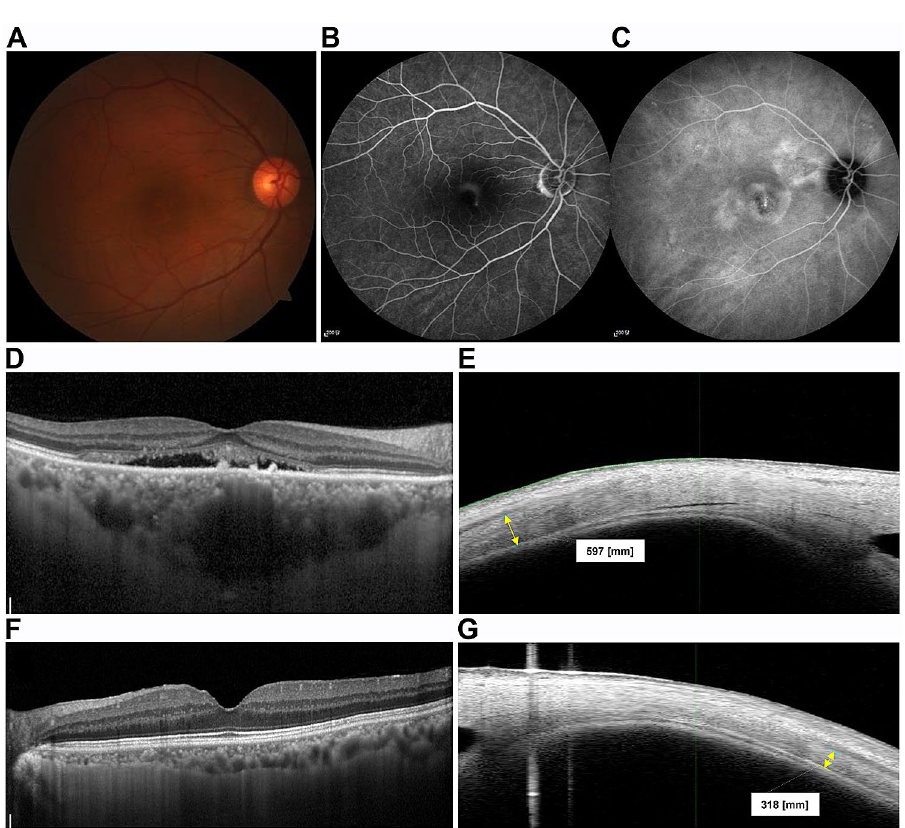
Figure 3. Representative cases of CSC eyes ( A – E ) and normal eyes ( F , G ). Color fundus photographs of CSC eyes show serous macular detachment ( A ) and fluorescein angiography shows typical smoke stack pattern of leakage ( B ). Late phase image of indocyanine angiography shows multiple areas of choroidal hyperpermeability. We observed very thick choroid in enhanced-depth imaging (EDI) of optical coherence tomography (OCT) and relatively thick sclera in swept source anterior segment (AS) OCT in CSC eyes ( D , E ), compared with those of normal eyes ( F , G